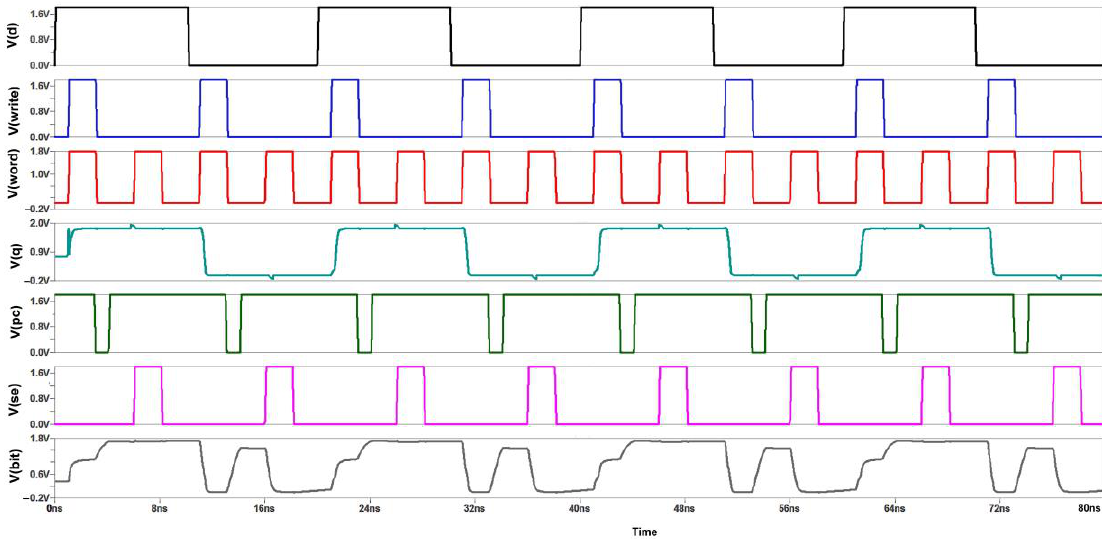
Figure 9. Output waveform of Basic Latch Sense Amplifier with Pass transistors.